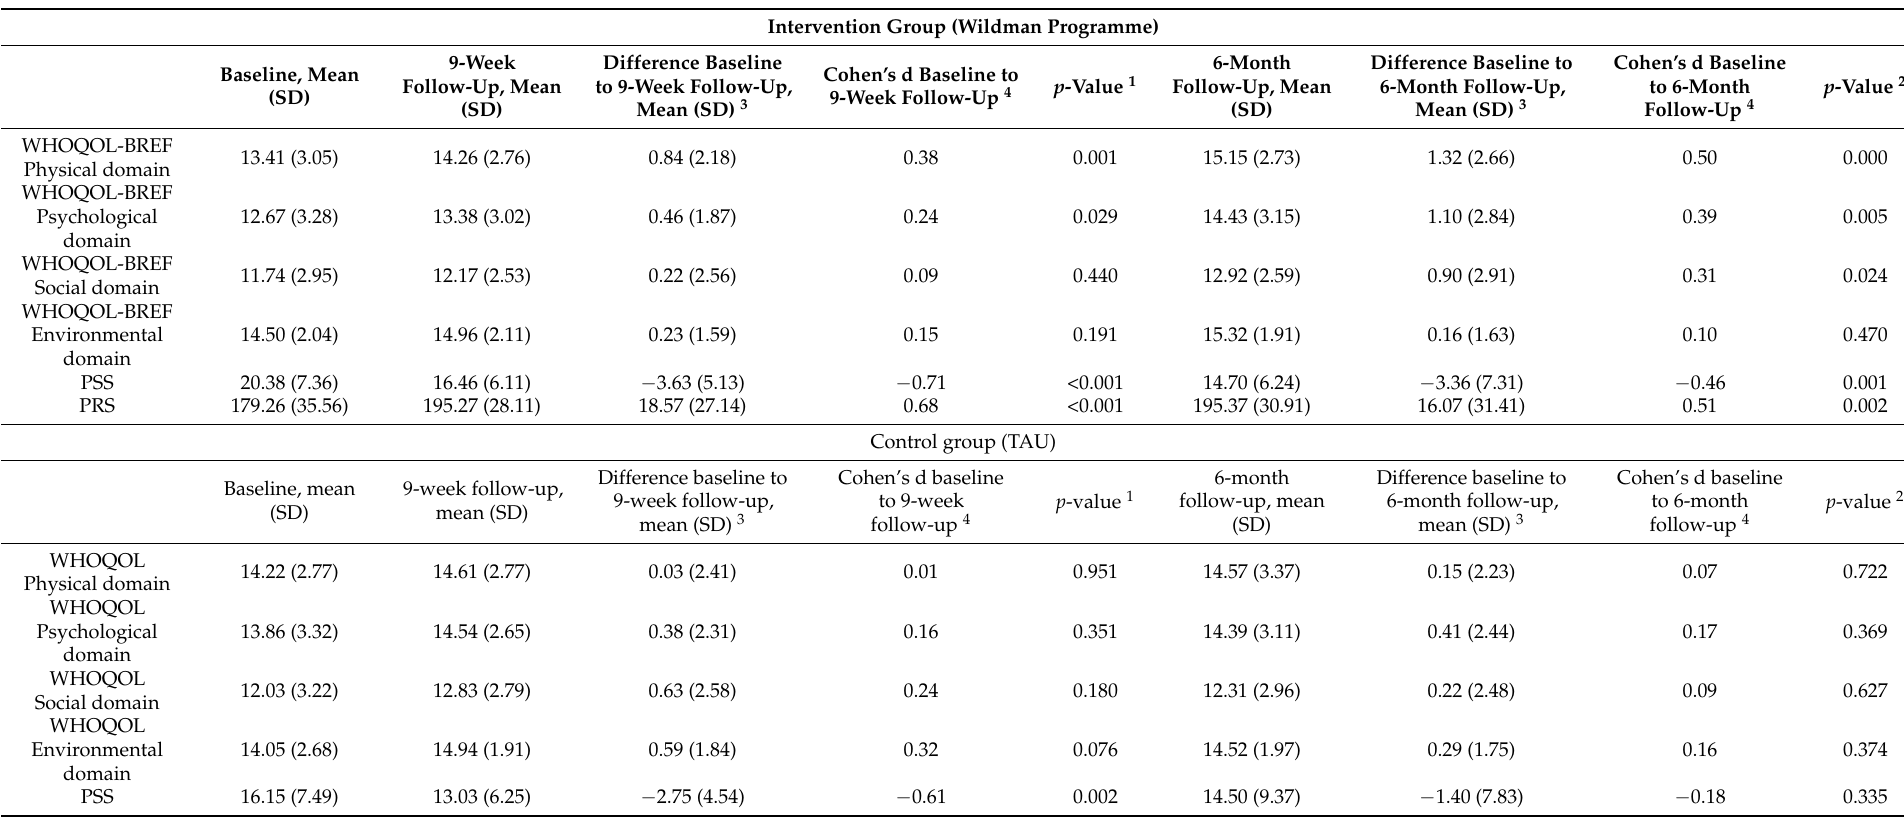
Table 2. Means of primary and secondary outcomes over time in the intervention group (Wildman Programme) and the control group (TAU), paired t -tests and effect size measure of difference (Cohen’s